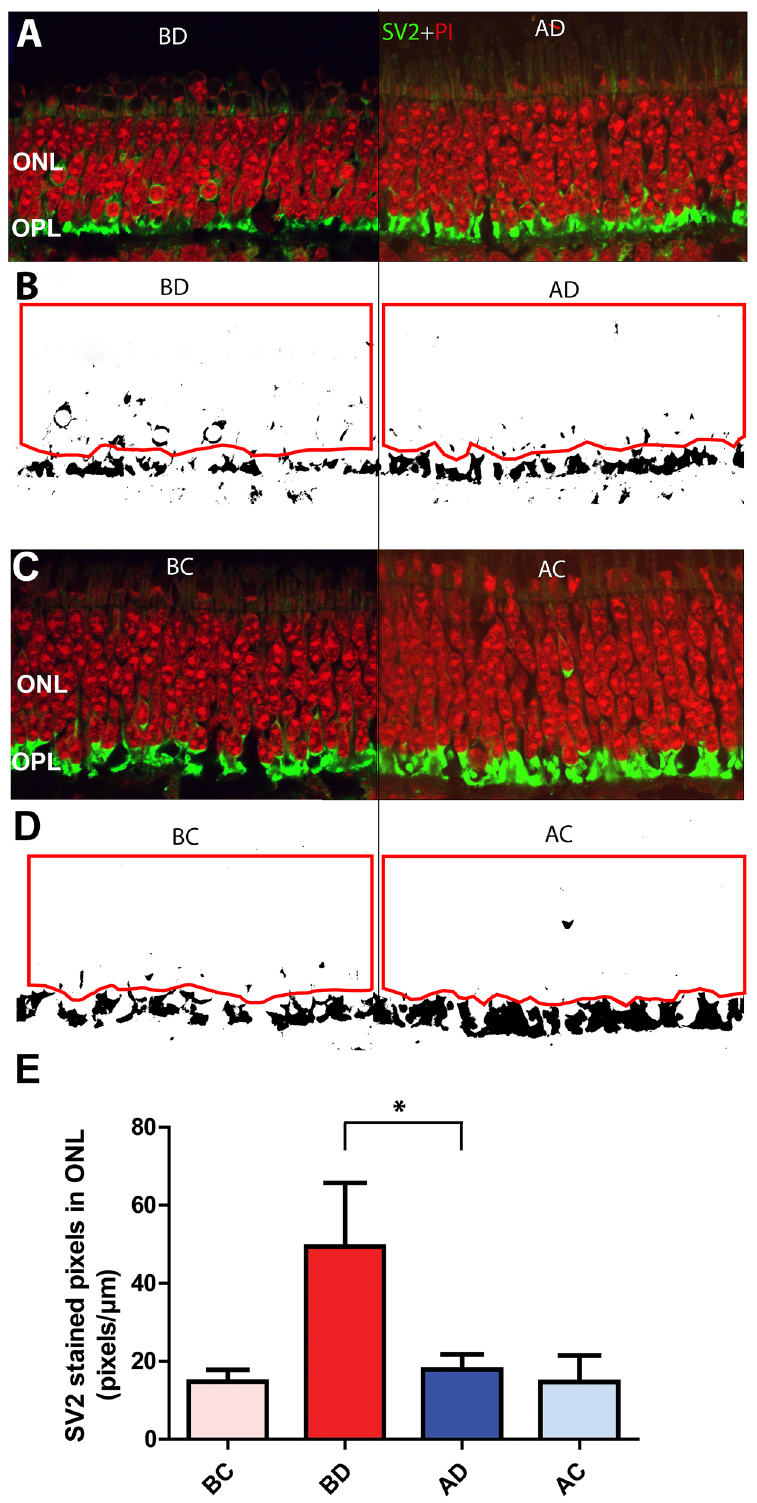
Figure 2. Effect of a subretinal dose of 0.5 μM AR13503 2 h after detachment. (A,C) Retina labeled for synaptic vesicle protein (SV2, green) and nuclei (propidium iodide, PI, red). Retracted rod spherules in the ONL are abundant in the sample from BSS eye detached area (BD) . (B,D) Binary mask created for SV2 channel for data analysis. Red line indicates the outline of the ONL, where the amount of SV2 labeling was measured. ( E) There was significantly less rod spherule retraction in the AR13503-treated detached area (AD) compared to the detached area from the untreated eye (n = 3 animals, *p = 0.001, using 120 images/animal, + /− SD). BC, AC, attached areas of the untreated and treated